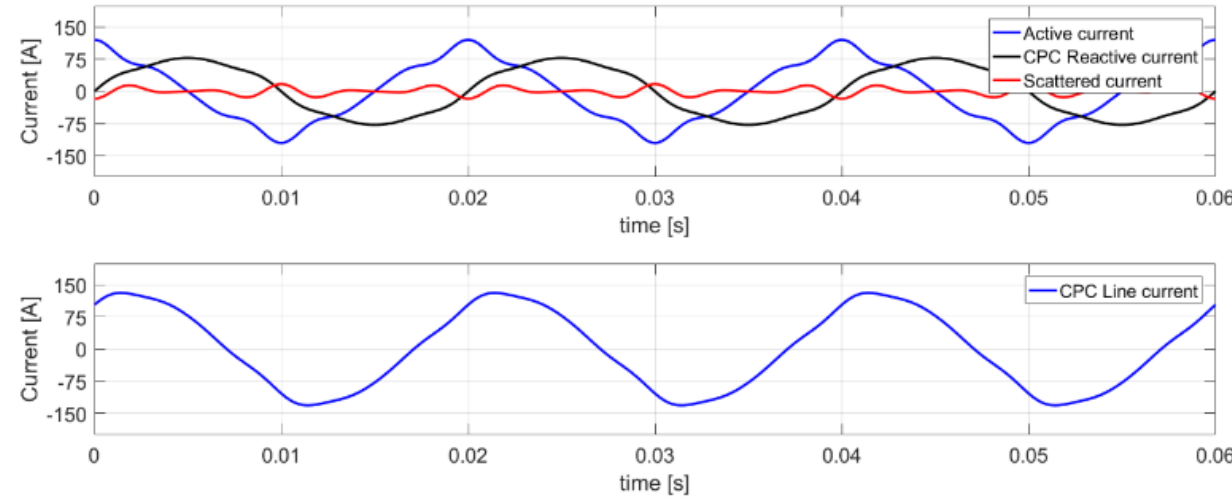
Figure 5. The waveform of the currents’ components and current of the load in CPC theory.